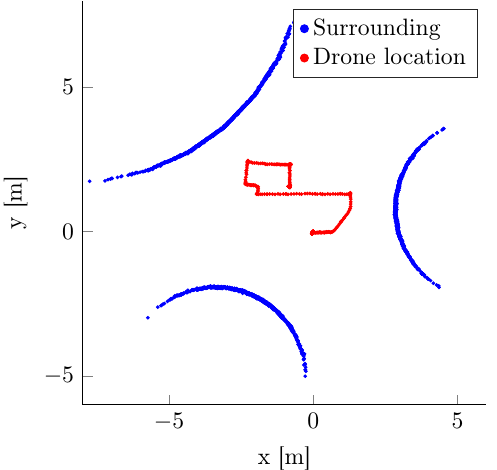
Figure 4. The map is shown in blue, the flight path in red. The simulated environment consists of three large cylinders. Due to this geometry, simplified SLAM methods like OrthoSLAM would not perform well in this